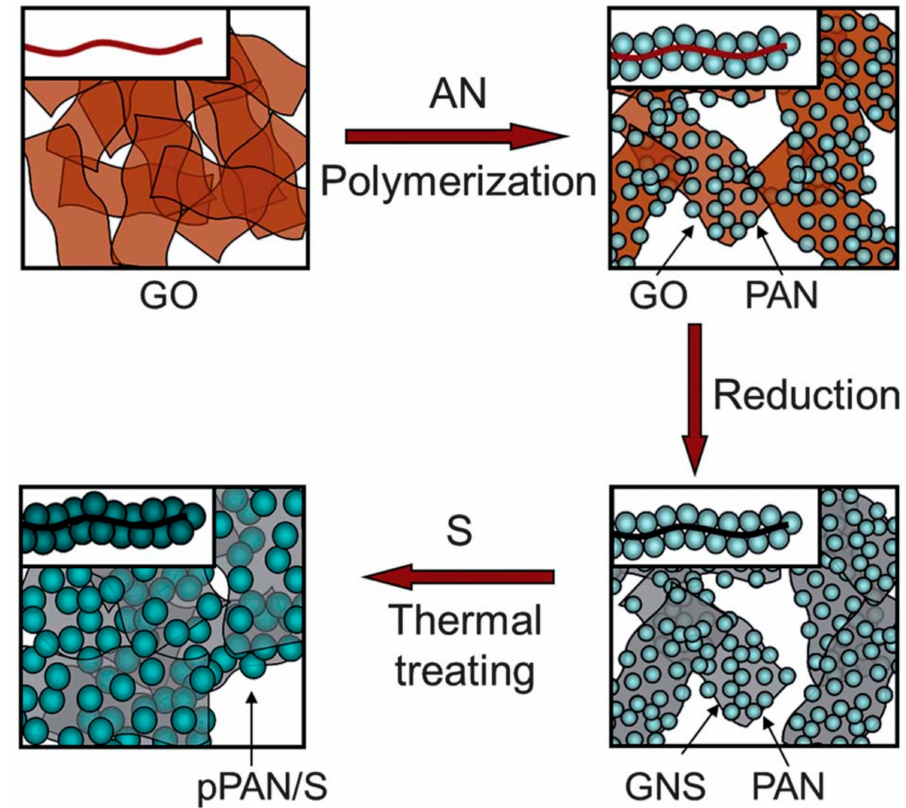
Figure 9. Preparation of polyacrylonitrile (PAN)-based CF composites. Reprinted with permission from [82]. Copyright The Royal Society of Chemistry